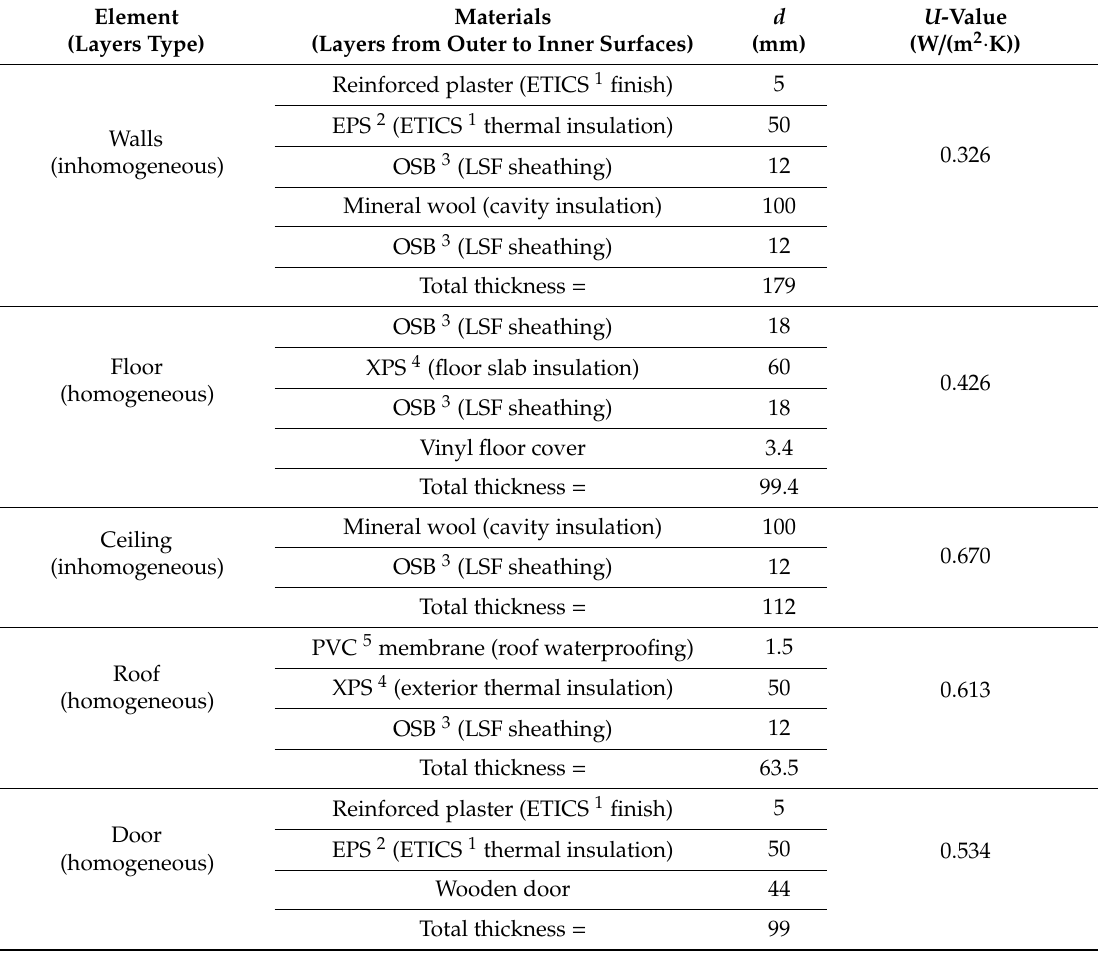
Table 2. Materials, thicknesses ( d ), and thermal transmittances ( U ) of the LSF